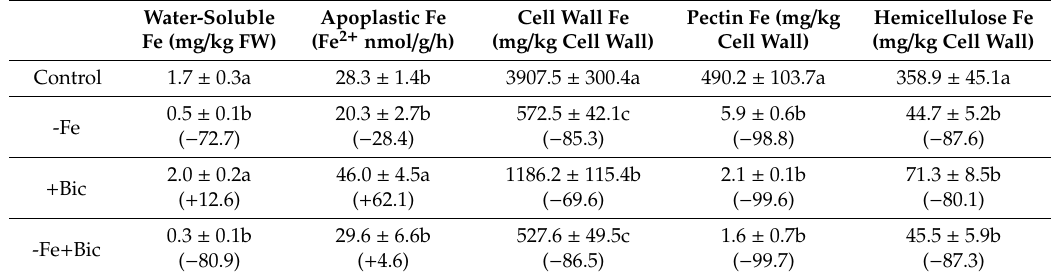
Table 3. The concentrations of water-soluble Fe, apoplastic Fe, cell wall Fe, pectin Fe, and hemicellulose Fe in roots of kiwifruit plants treated with -Fe, + Bic or -Fe + Bic in solution culture for 35 days. Values are means of five replicates ± SE. Di ff erent letters indicate significant di ff erences among the treatments for each given parameter at p < 0.05. Values inside parentheses represent the percent change (%) in treated plants when compared with the control ones. FW, fresh